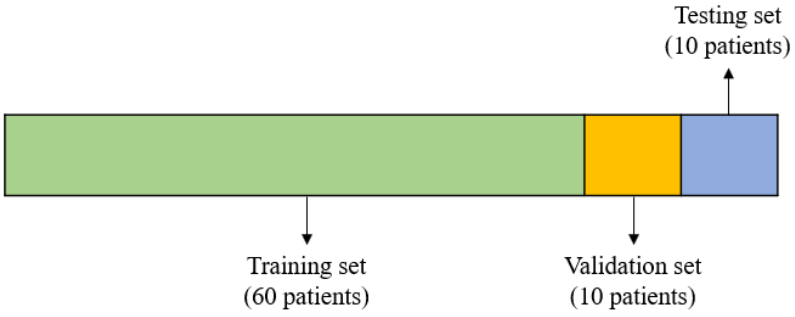
Figure 8. Illustration of the holdout method.